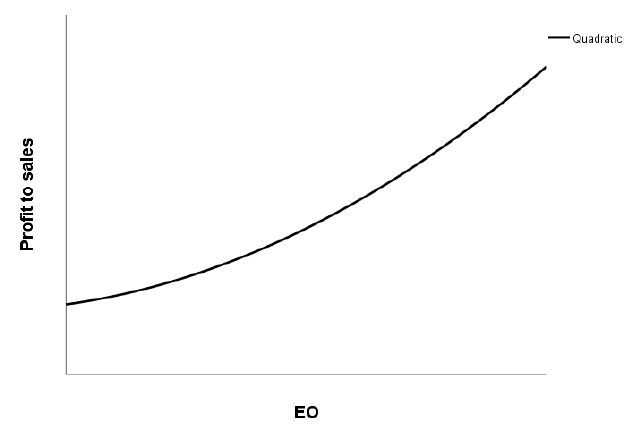
Figure 3. Nonlinear effect of EO on profit ‐ to ‐ sales.